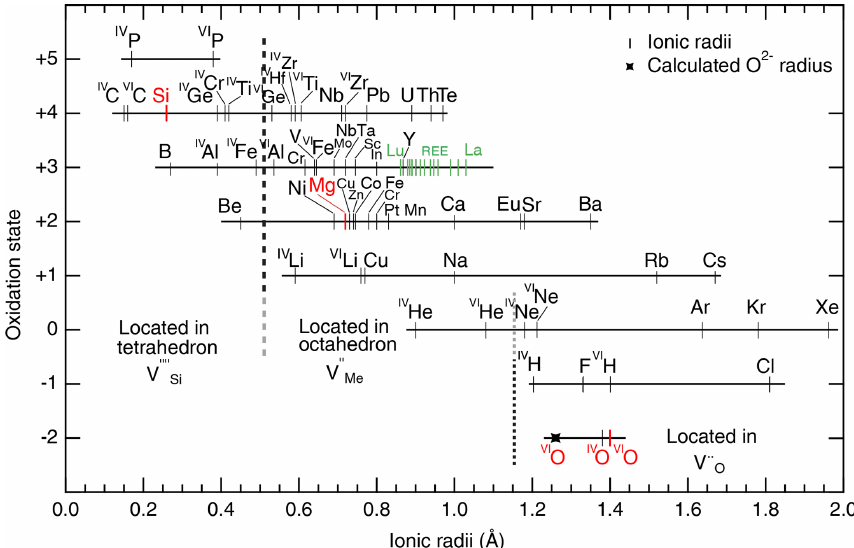
Figure 5. Ionic radii of cations and anions in olivine as a function of oxidation state. Ionic radii are from Shannon (1976), except for noble gases, which are from Zhang and Xu (1995). Note that the high-spin state is reported for the transition metals (as in De Hoog et al., 2010). The calculated ionic radius of O 2 − from Fumi and Tosi (1964) is also shown for comparison. H could not be included because, to date, the ionic radius of H + in silicates is not known with satisfying accuracy. To guide the eye, Si, Mg, and O are shown in red; the different positions for different coordinations of oxygen are also given, and vertical dashed lines delimit the approximate ranges of ion incorporation into Si, Mg, and O